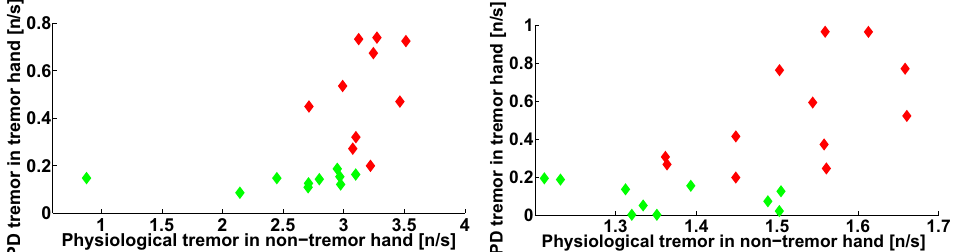
Figure 21. The scatter plot of the numbers of wave trains per second detected in the extensor muscle of the tremor and non-tremor arms of PD patients. The abscissa axis indicates the wave train numbers corresponding to the physiological tremor in the non-tremor hand; the ordinate axis indicates the wave train numbers corresponding to the Parkinsonian tremor in the tremor hand. The PD patients are indicated by the red color; the control subjects are indicated by the green color. On the left, the left-hand-tremor PD patients are shown. On the right, the right-hand-tremor PD patients are